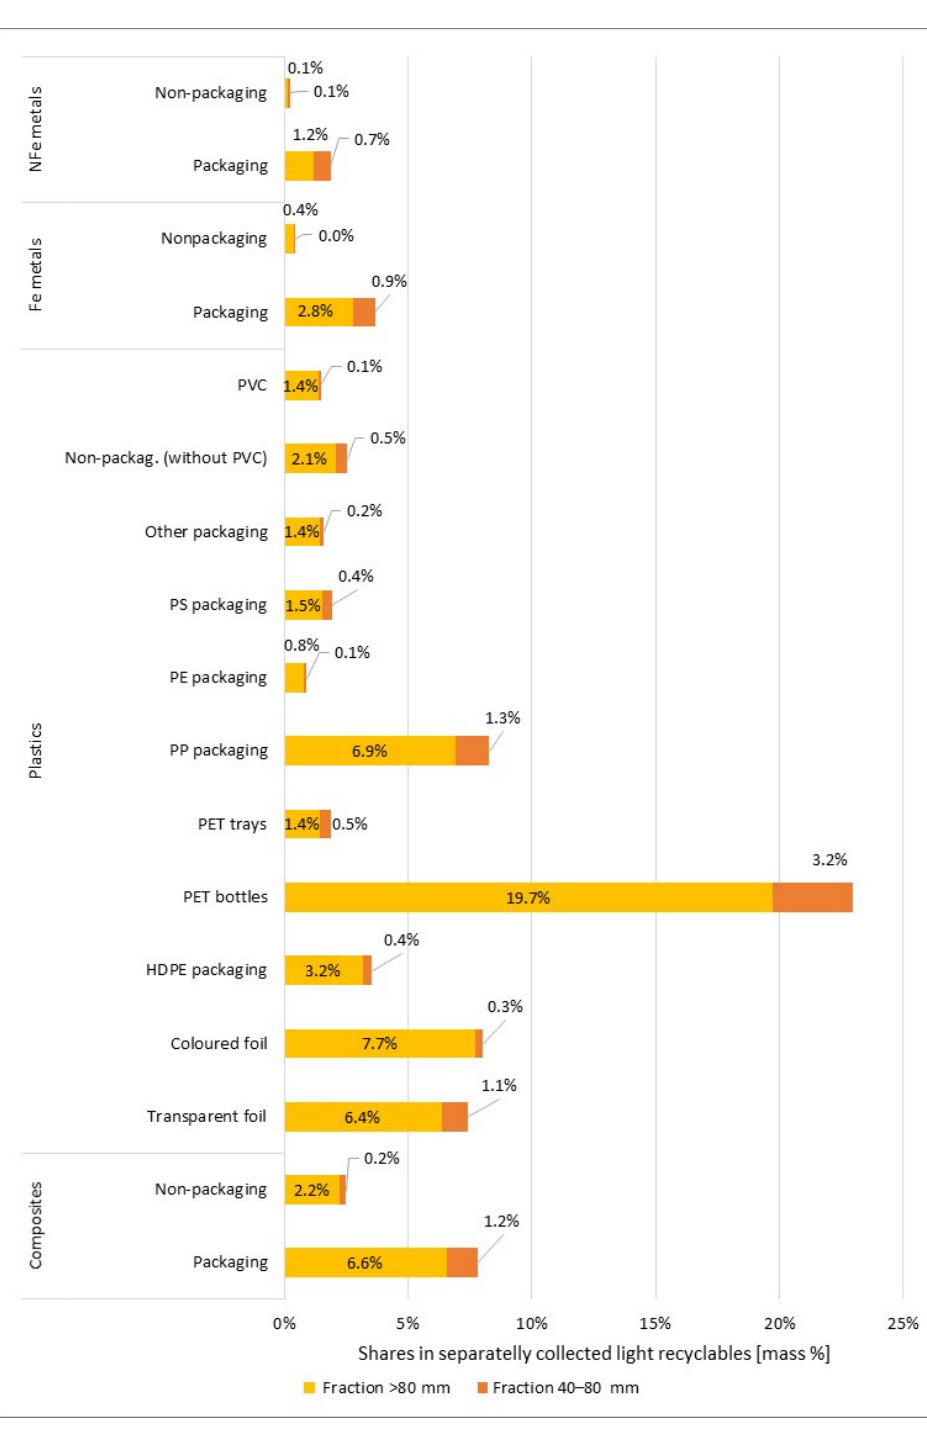
Figure 4. Detailed composition of >40 mm fractions of separately collected light recyclables.